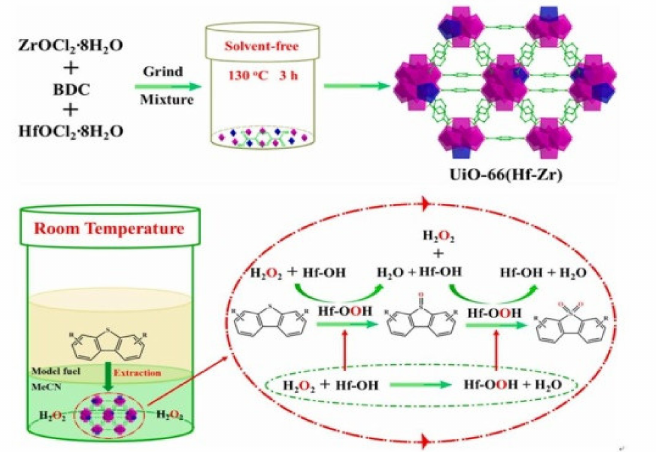
Figure 2. Schematic illustration about the synthetic process of UiO-66(0.13Hf-Zr) and proposed ODS